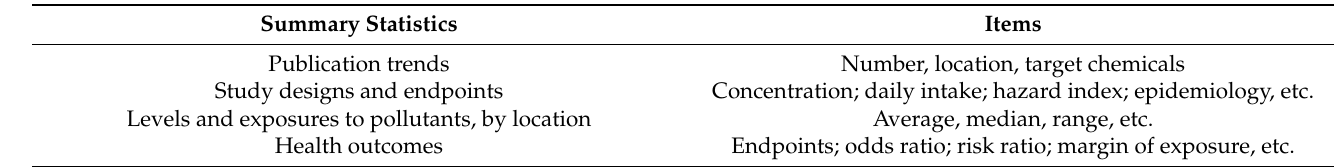
Table 3. Output of systematic review and synthesis of the